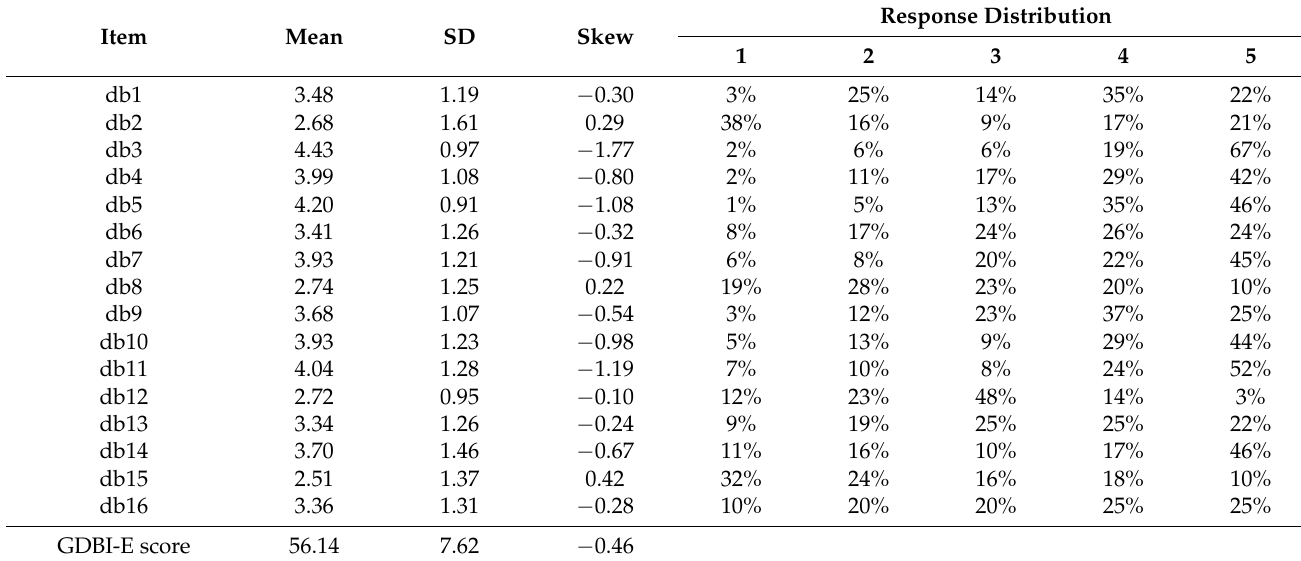
Table 1. Item statistics of GDBI-E